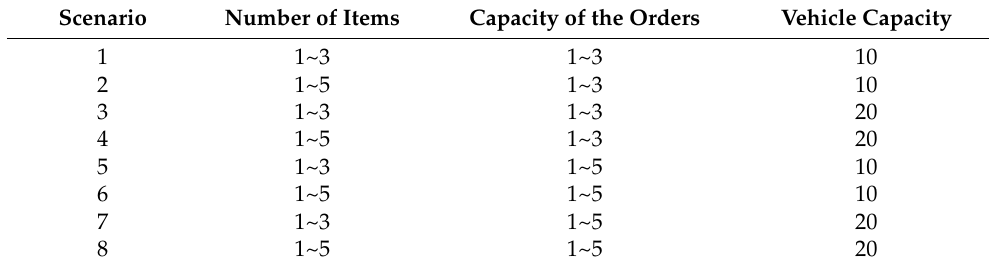
Table 1. Sample problems.